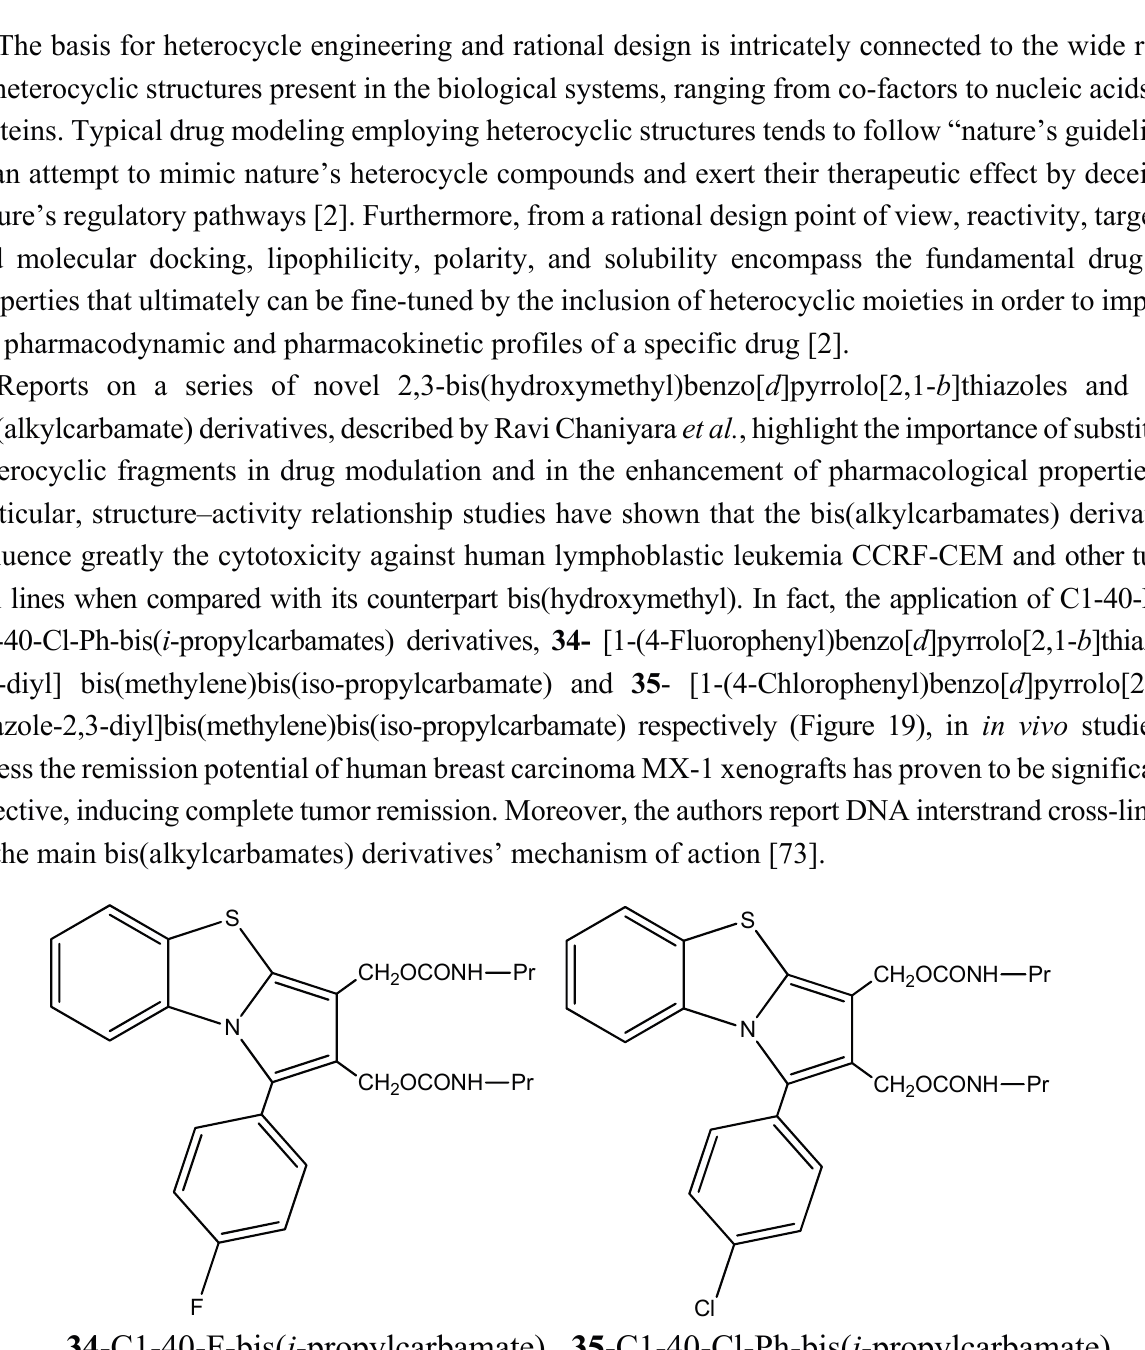
Figure 19. Benzo[ d ]pyrrolo[2,1- b ]thiazole with bis( i -propylcarbamates) derivatives with proven cytotoxic activity against lymphoblastic leukemia CCRF-CEM and human breast carcinoma MX-1 xenografts